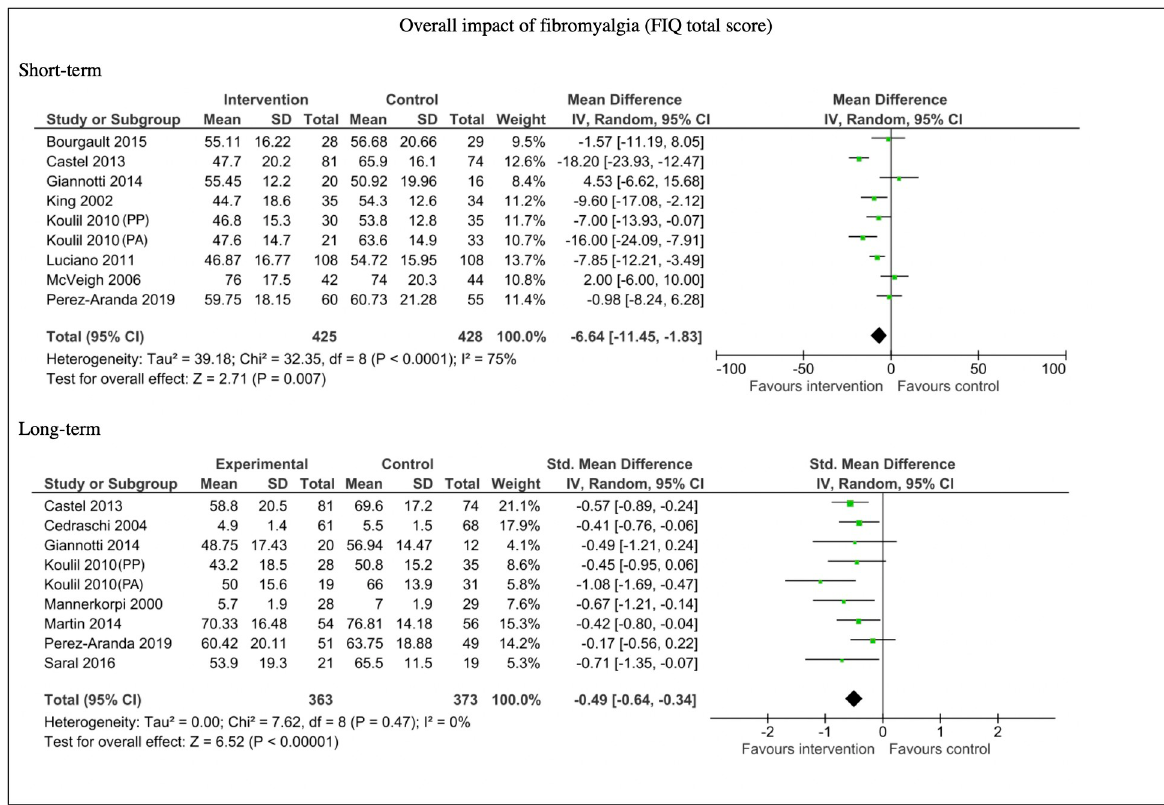
Fig 6. Forest plots of comparisons for impact measures (total FIQ score) for intervention compared to waitlist/no treatment/usual care controls.